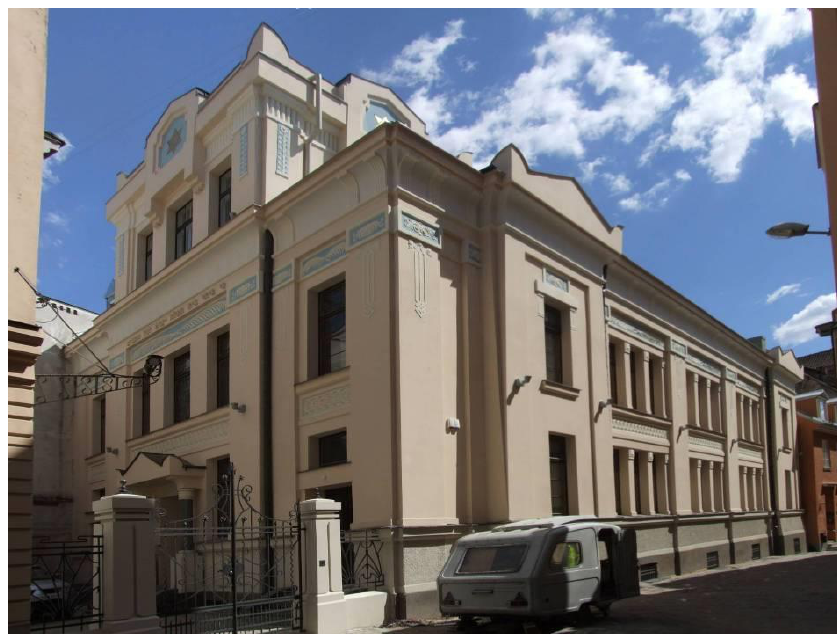
Figure 9. The Peitavas Street Synagogue in Riga, architects Karl R. H. Seuberlich and Wilhelm K. Neumann, 1903 – 1905. Photo by the author, 2009.